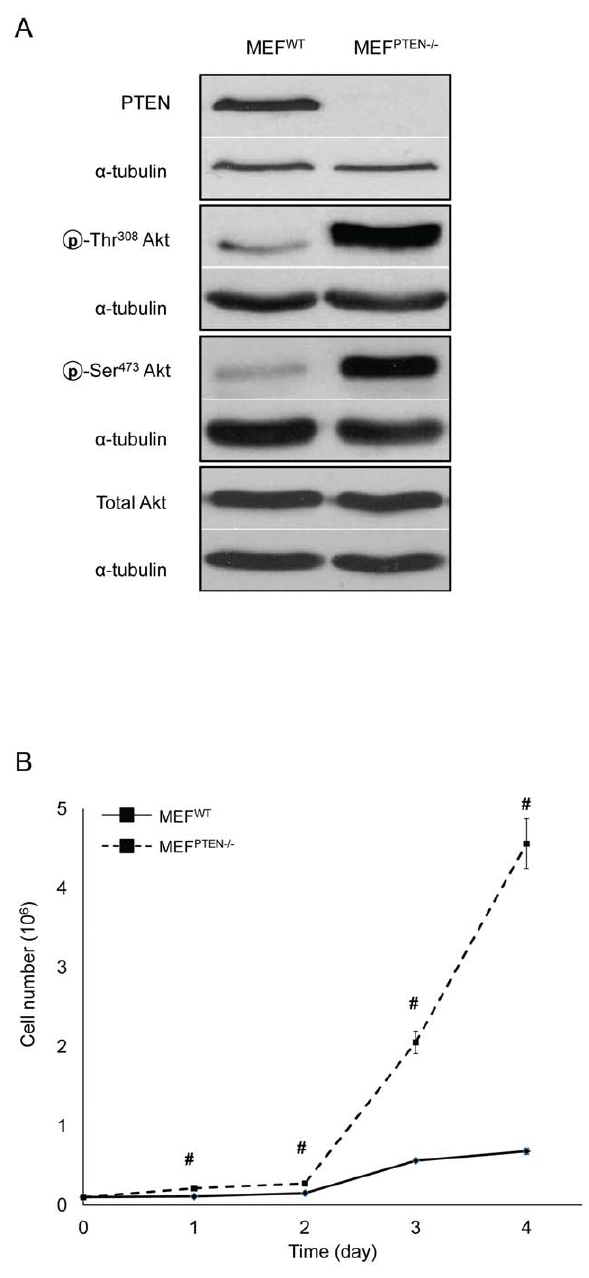
Figure 1. Characterization of MEF PTEN 2 / 2 . ( A ) Western blot analyses of PTEN, Akt, p-Ser 473 Akt and p-Thr 308 Akt Immunoblotting of PTEN, Akt, p-Ser 473 Akt and p-Thr 308 Akt was carried out on whole cell lysates of MEF WT and MEF PTEN 2 / 2 . The loss of PTEN in MEF PTEN 2 / 2 resulted in hyperactivation of Akt on both phosphorylation sites without affecting the expression of total Akt. The respective loading controls of a -tubulin were included. ( B ) Rate of cell proliferation This was measured by the trypan-blue exclusion assay. The MEF PTEN 2 / 2 has a significantly higher rate of proliferation compared to MEF WT from days 1–4 of culture. # p , 0.005 for